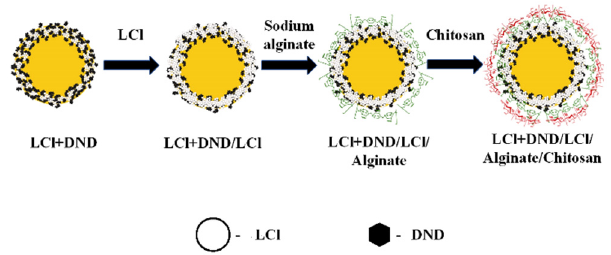
Figure 7. The scheme of the capsule formation.